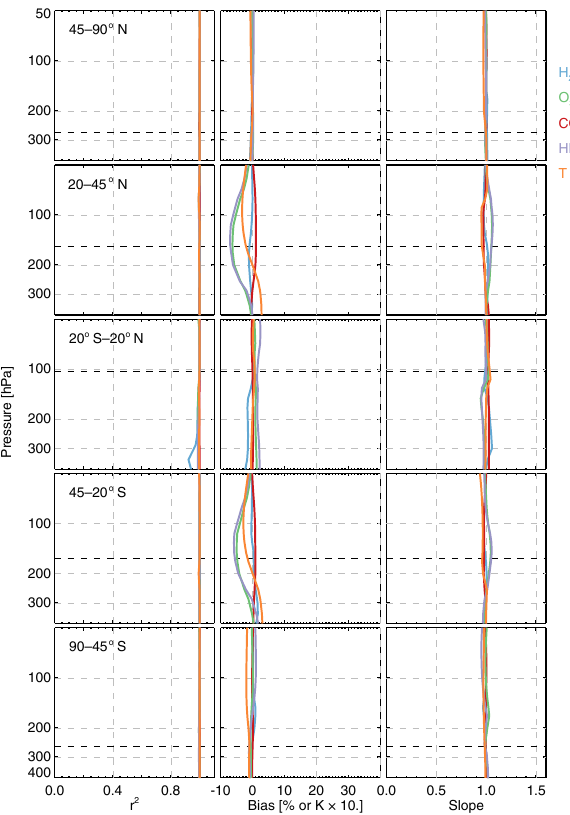
Figure 6. Vertical profiles of the coefficient of determination, the bias, and the linear fit slope for different latitude bands for the MI- PAS vs CMAM30-SD scatter using the full satellite-sampled fields. Note that for clarity the temperature bias is shown as K × 10. Blue, green, red, purple, and orange lines represent H 2 O, O 3 , CO, HNO 3 , and temperature metrics. The dashed black lines show the mean 2005 thermal tropopause derived from MERRA2 for the particular latitude bands.